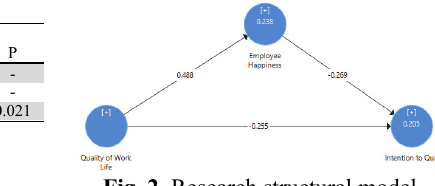
Fig. 2. Research structural